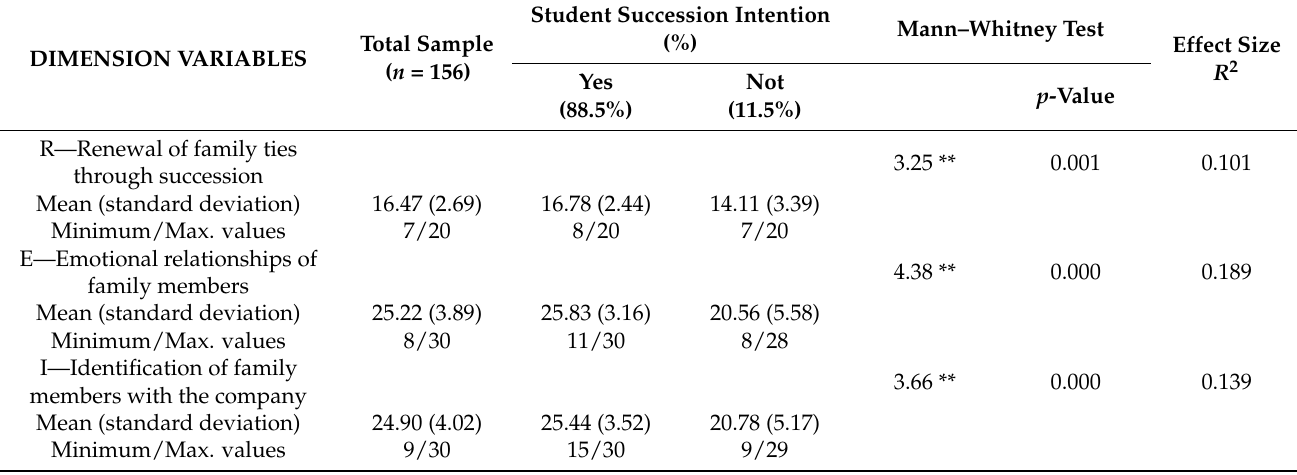
Table 7. Comparative inferential analysis. Differences in the SEW based on the students’ succession intention ( n = 156).